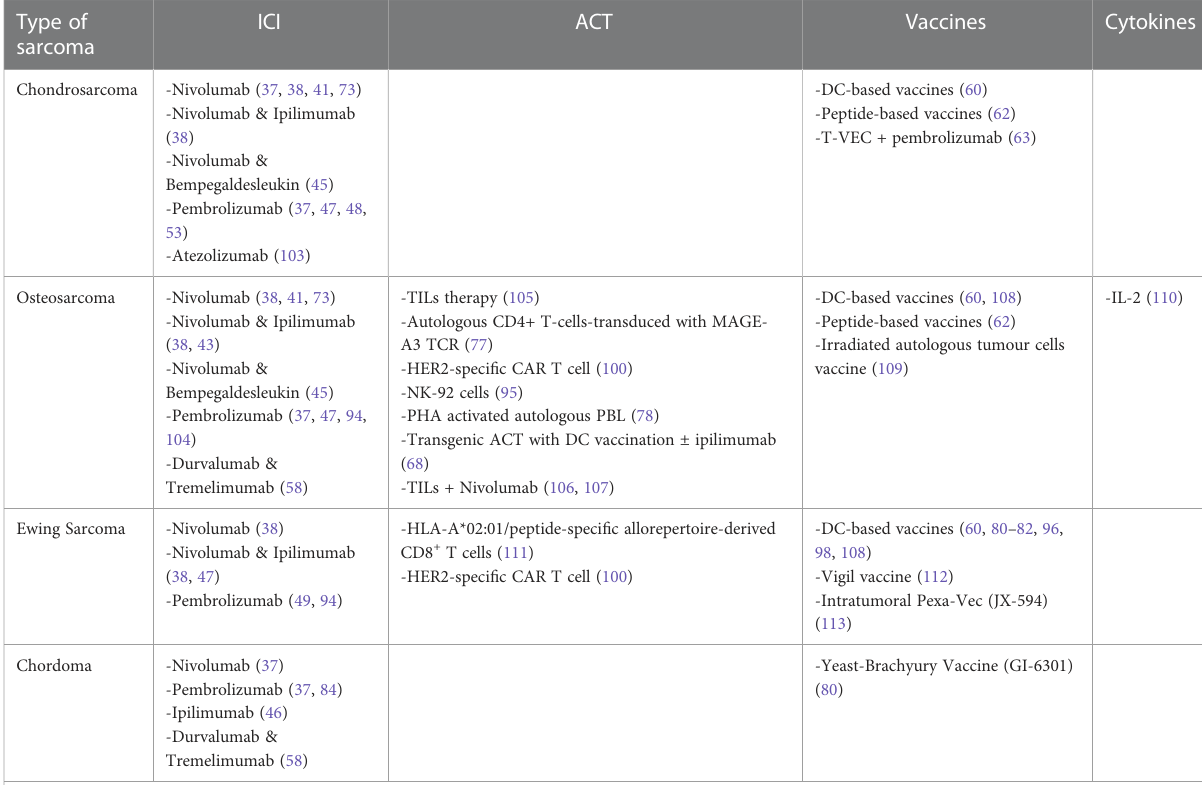
TABLE 2 Different types of immunotherapies that have been investigated in selected histological types of BS. Type